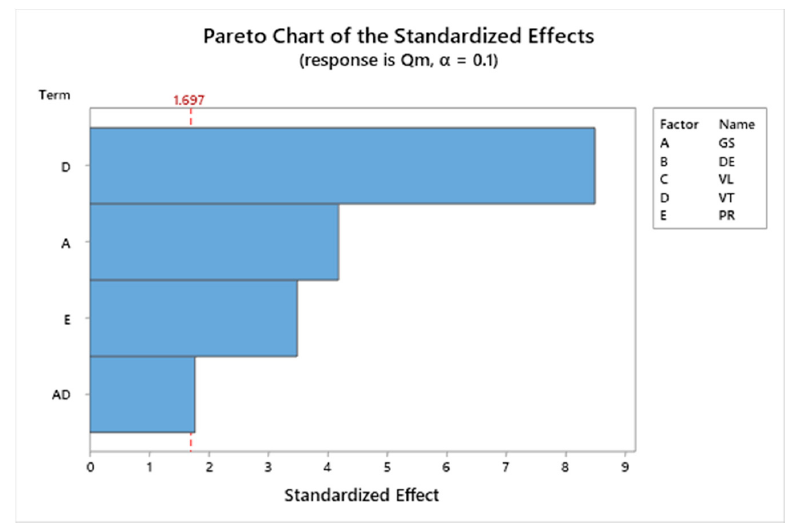
Figure 8. Pareto chart of the standardized effects for material removal rate Qm.